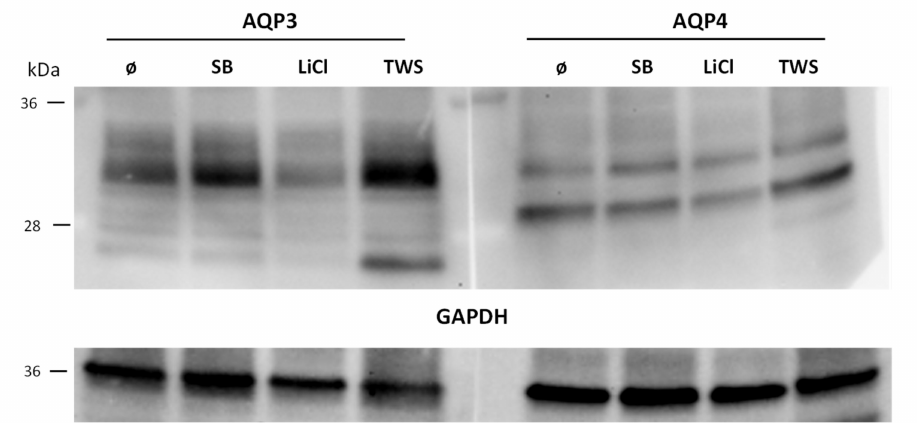
Figure 7. E ff ect of LiCl and GSK3 inhibition on Aqp3 and Aqp4 expression. The expression of Aqp3 (left panel) and Aqp4 (right panel) in IMCD cells treated with either LiCl (20 mM / 24 h), GSK3 α / β inhibitor SB216763 (SB; 10 µ M / 24 h), or GSK3 β TWS119 (TWS; 10 µ M / 24 h) was analyzed by Western blot. Afterwards, the antibodies were stripped, and the membrane was incubated with GAPDH (n =